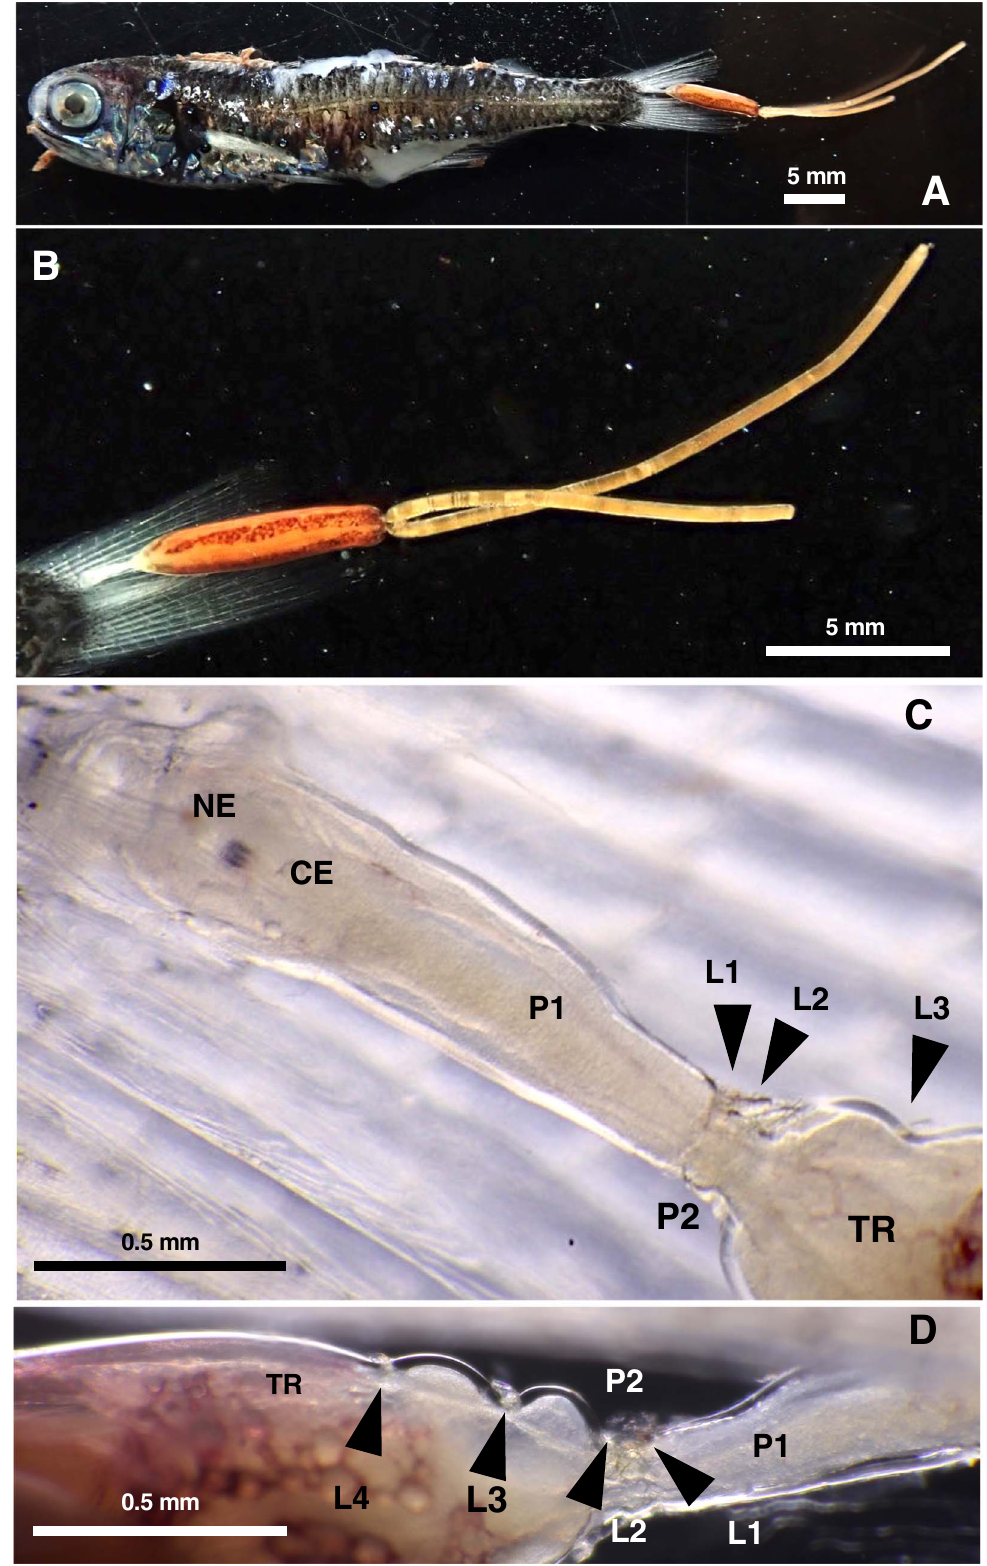
Figure 1. Peniculus hokutoae n. sp., holotype female. (A), (B) Living specimen in-situ on caudal fin of host Symbolophorus evermanni (Gilbert, 1905); (C) Cephalothorax and neck, dorsal view; (D) Neck and anterior part of trunk, lateral view. Abbreviations: CE: dorsal cephalic shield; L1–4: legs 1–4; NE: naupliar eye; P1, 2: pedigerous somites 1 and 2; TR: